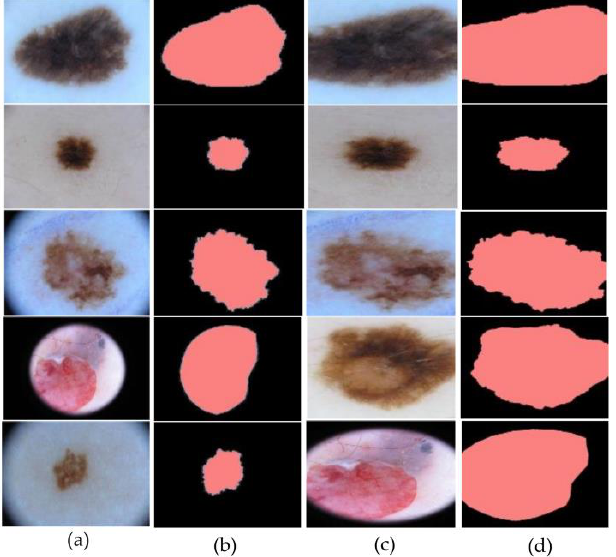
Figure 6. Visualisation results ( a ) input image of ISIC 2016 ( b ) segmented output of ISIC 2016 ( c ) input image of ISIC 2017 ( d ) segmented output of ISIC 2017.